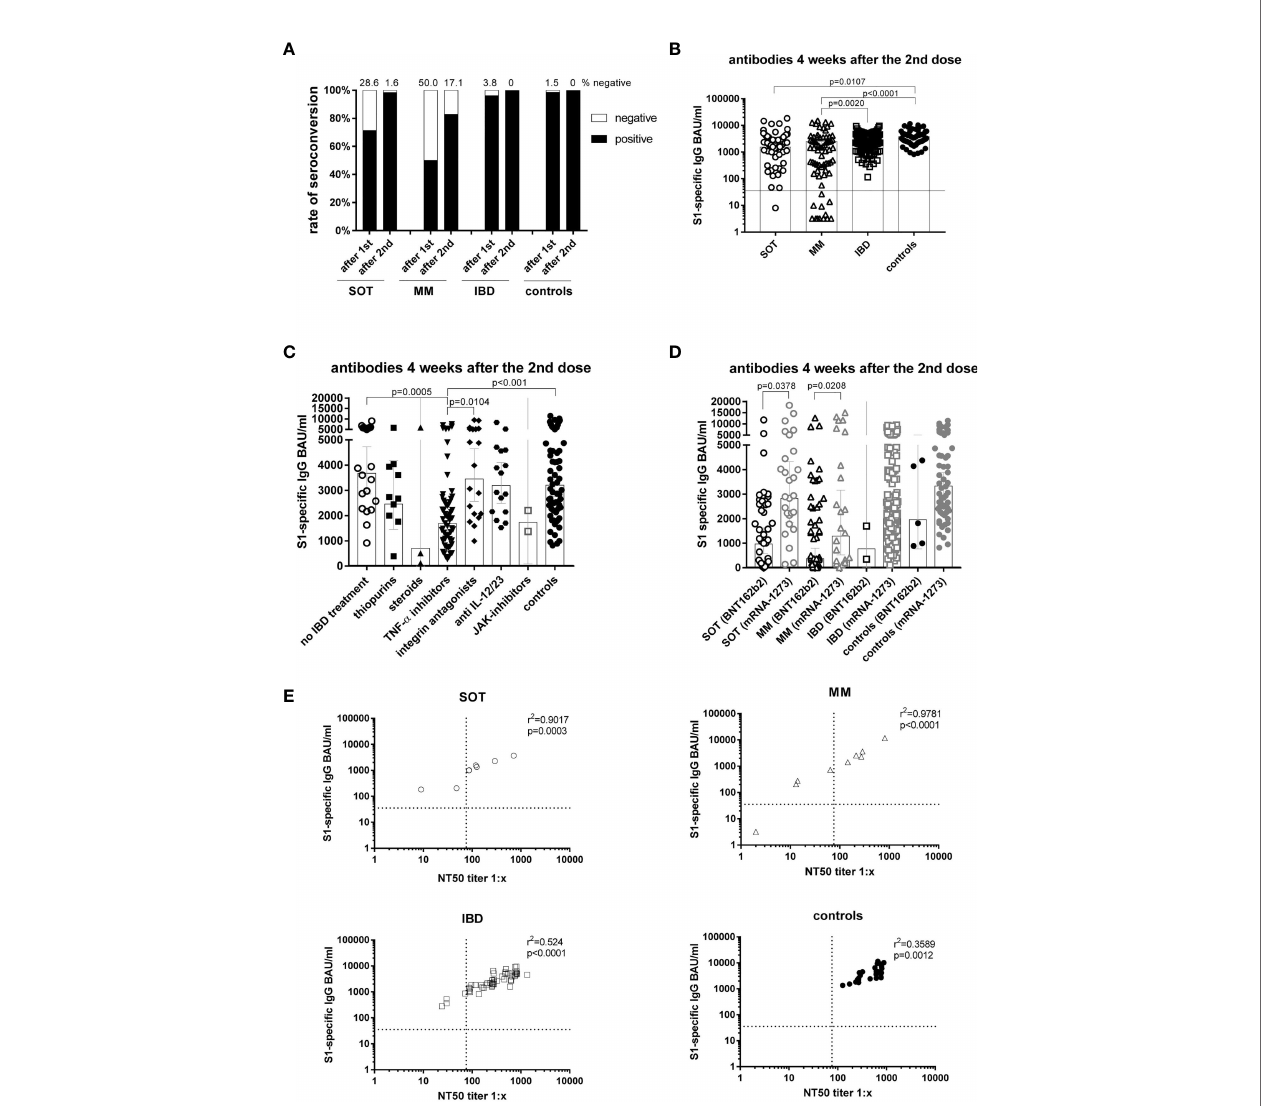
FIGURE 1 | Antibody responses four weeks after the second mRNA vaccination and correlation of S1-speci fi c IgG with neutralizing antibodies. Seroconversion rates after the fi rst and second dose in all study participants of all groups (A) . Individual S1-speci fi c IgG levels of all participants (B) . S1-speci fi c IgG levels of IBD patients in respect of their treatment and in comparison to the controls (C) . S1-speci fi c antibody levels in relation to the type of mRNA vaccine applied (BNT162b2 or mRNA- 1273), whereby due to the number of participants statistical differences could only be calculated for SOT and MM patients (D) . Correlation of S1-speci fi c IgG levels with the NT50 of a neutralization test with sera taken four weeks after the second vaccination (n=106) (E) . SOT (n=63) are represented as circles, MM (n=70) as triangles, IBD (n=130) patients as squares and controls (n=55) as full black or grey circles. Differences between the groups below p values of 0.05 were regarded as signi fi cant. The black and dotted lines (E) indicate the threshold for positive results (35.2 BAU/ml and NT50). Bars (B-D) represent GMC with 95% con fi dence interval